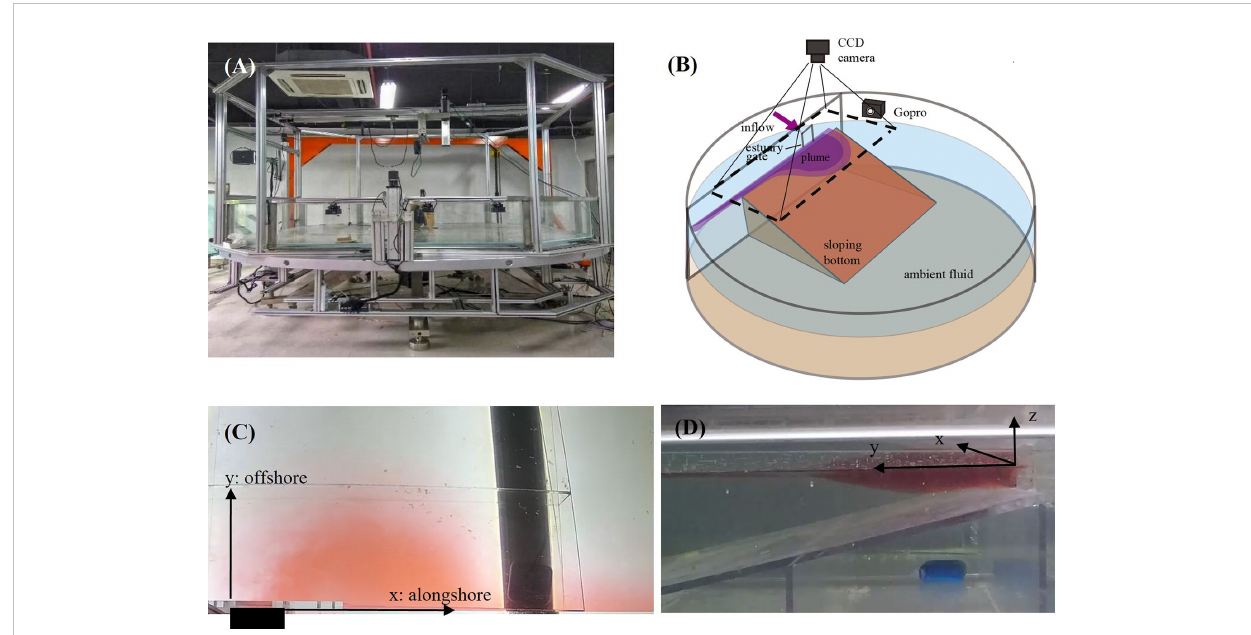
FIGURE 2 Schematic of the experimental setup. (A) Photo of the rotating table. (B) The setup of the cameras and bottom slope over the circular fl ume, (C) and (D) show the fi eld of view captured by the top-mounted CCD camera and the side-mounted Gopro,